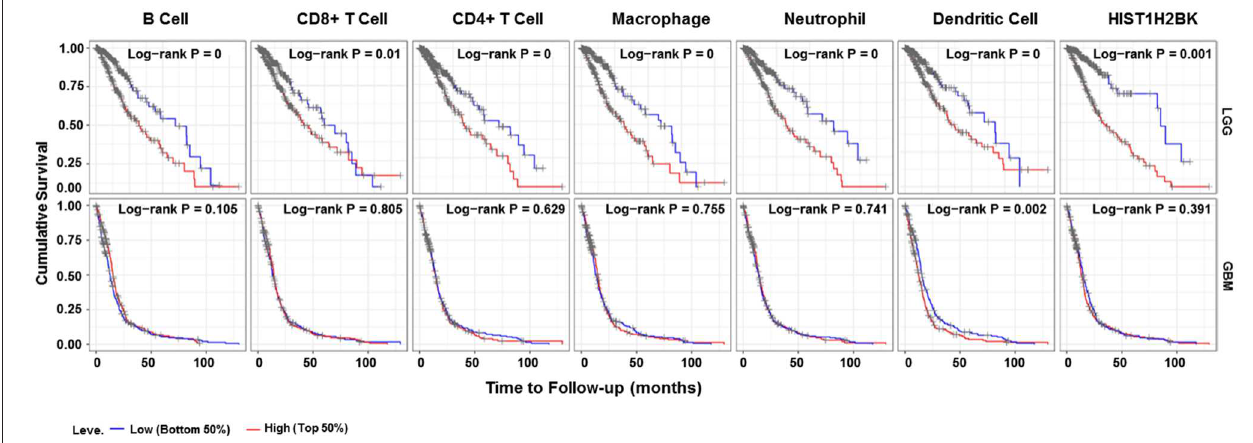
FIGURE 6 | Survival curve for immune cell infiltration. Kaplan–Meier survival curves based on top and bottom sample partitions with 50% immune penetration. Red indicates a high degree of infiltration and blue indicates a low degree of infiltration. P < 0.05 was considered significant, and P < 0.0001 was reported as 0. GBM, glioblastoma; LGG, low grade glioma.